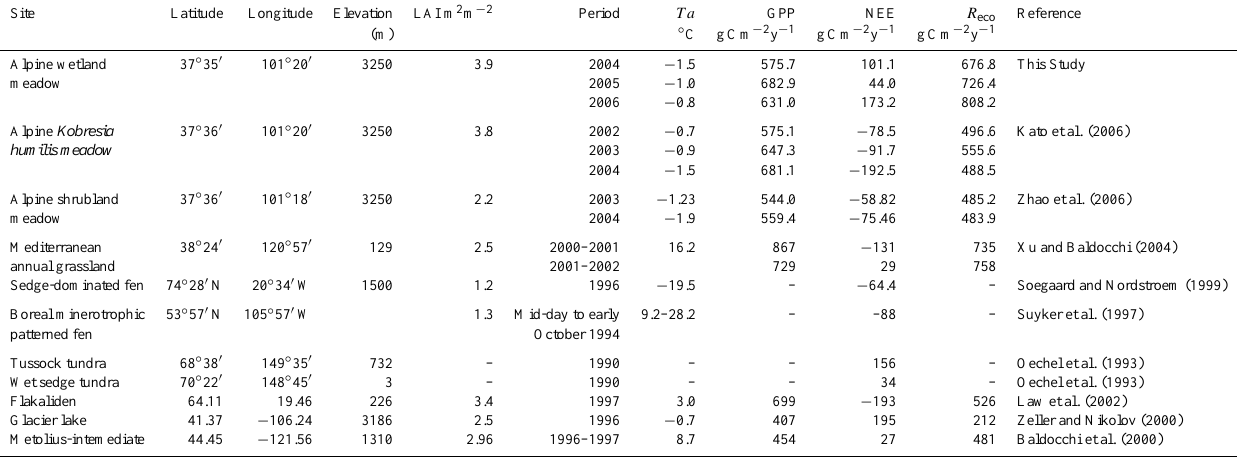
Table 2. Published study sites characteristics, environmental variables and carbon fluxes.